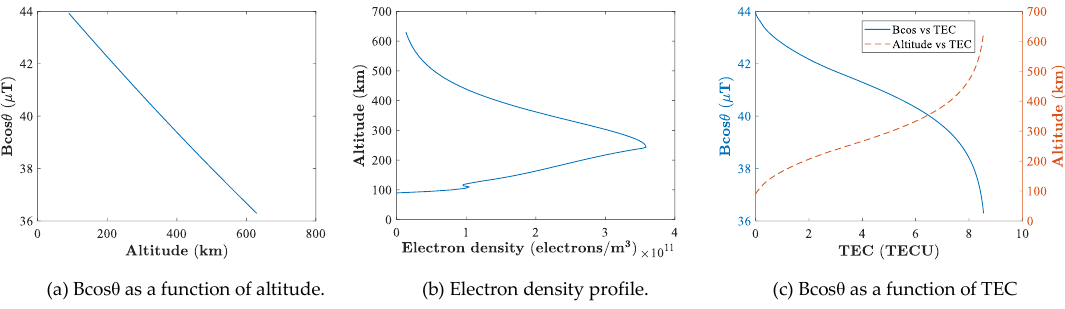
Figure 3. Relationship between altitude and total electron content (TEC) as well as B cos θ .